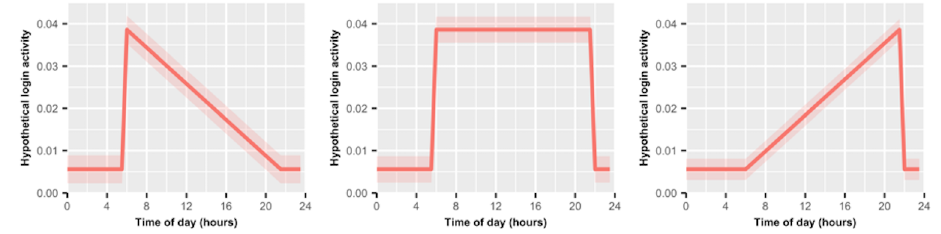
Fig 2. Theoretical models of user activity as a function of time of day. Models of user behavior basedon different self-control theories. Solid line represents hypothesized averagebehavior for a sample throughout the day, Coloredregionis hypothesizedstandarddeviation.(A) Assumes that a domain-general reserve is requiredfor all self-control and requiresrest to refill. (B) Assumes that self-control is stable throughoutnormal wakinghours and has no limits. (C) Assumes self-control is stable throughoutnormal wakinghours, and additionally that peoplehave the most opportunityfor personal projects later in the evening. Figures present parameters for login activity, each analysisis definedby its own